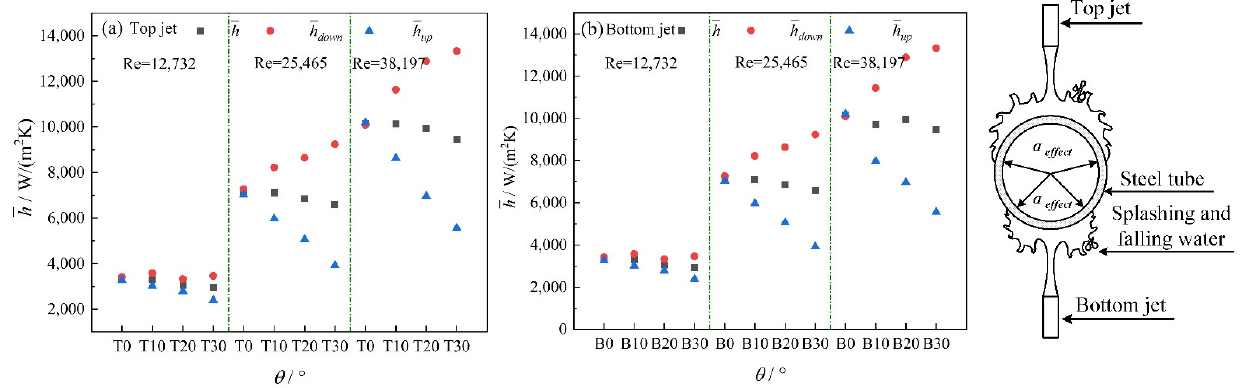
Figure 13. Comparison of the average heat transfer coefficient ( h ) between the downstream region and the upstream region under different Reynolds numbers. ( a ) Top jet; ( b ) Bottom jet. The cooling characteristics of the downstream region and upstream region of steel tube under different inclined angles were studied and compared. As shown in Figure 14, when the tilt angle increases from 0° to 30°, the difference in average heat transfer coeffi- cient between the downstream and upstream region gradually increases. When the tilt angle increases to 30°, the effect of the tilt angle on the average heat transfer coefficient is obviously stronger than that of jet position. As can be seen from the figure, when the Reynolds number is 38,197, the average heat transfer coefficient of the top jet is 9451 W/(m 2 K), and the average heat transfer coefficient of bottom jet decreases by less than 4%. However, compared with the average heat transfer coefficient in the upstream and down- stream region at this time, it is found that the average heat transfer coefficient in the down- stream region increases by more than 40%, while the average heat transfer coefficient in the upstream region decreases by 41%. This shows that when the tilt angle is too large, the difference between the average heat transfer coefficient of the downstream region and the upstream region is too large, which is not conducive to the improvement of cooling uni- formity. Based on the above studies on the impact cooling characteristics of the jet at dif- ferent positions under different Reynolds numbers, the target cooling rate of the steel tube was achieved by controlling the jet velocity in the actual application process, and the de- sired cooling uniformity was achieved and the tube shape was good.